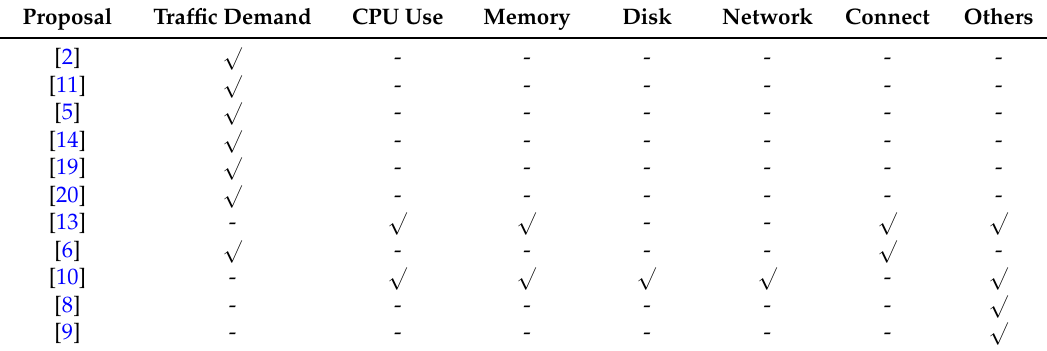
Table 1. Information monitored by each analyzed proposal. CPU: central processing